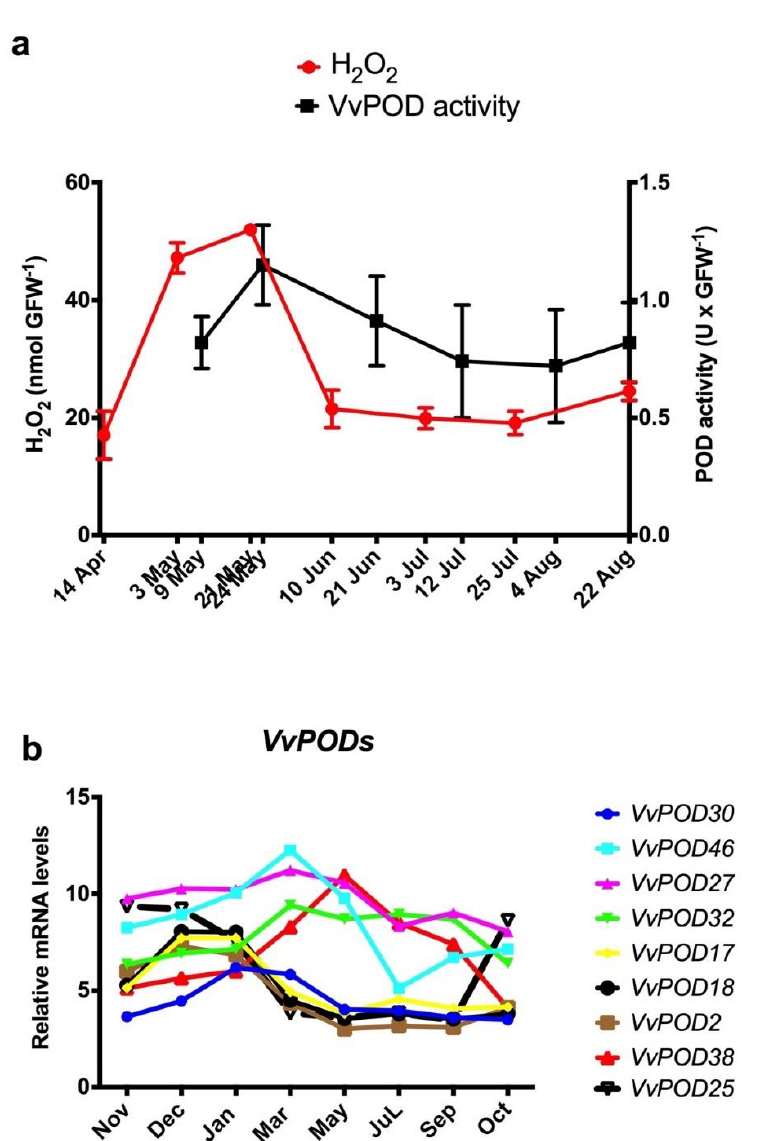
Figure 2. Expression of peroxidase genes ( VvPODs ), peroxidase activity and H 2 O 2 levels during grape bud endodormancy. ( a ) Relationship between H 2 O 2 levels and peroxidase activity (VvPOD) during endodormancy in Thompson seedless grapevine buds grown in Santiago, Chile. ( b ) Changes in the expression of peroxidase genes ( VvPOD ) throughout bud growth in Tempranillo grapevines grown in Alcalá de Henares, Madrid [21] and adapted to the Southern Hemisphere conditions.